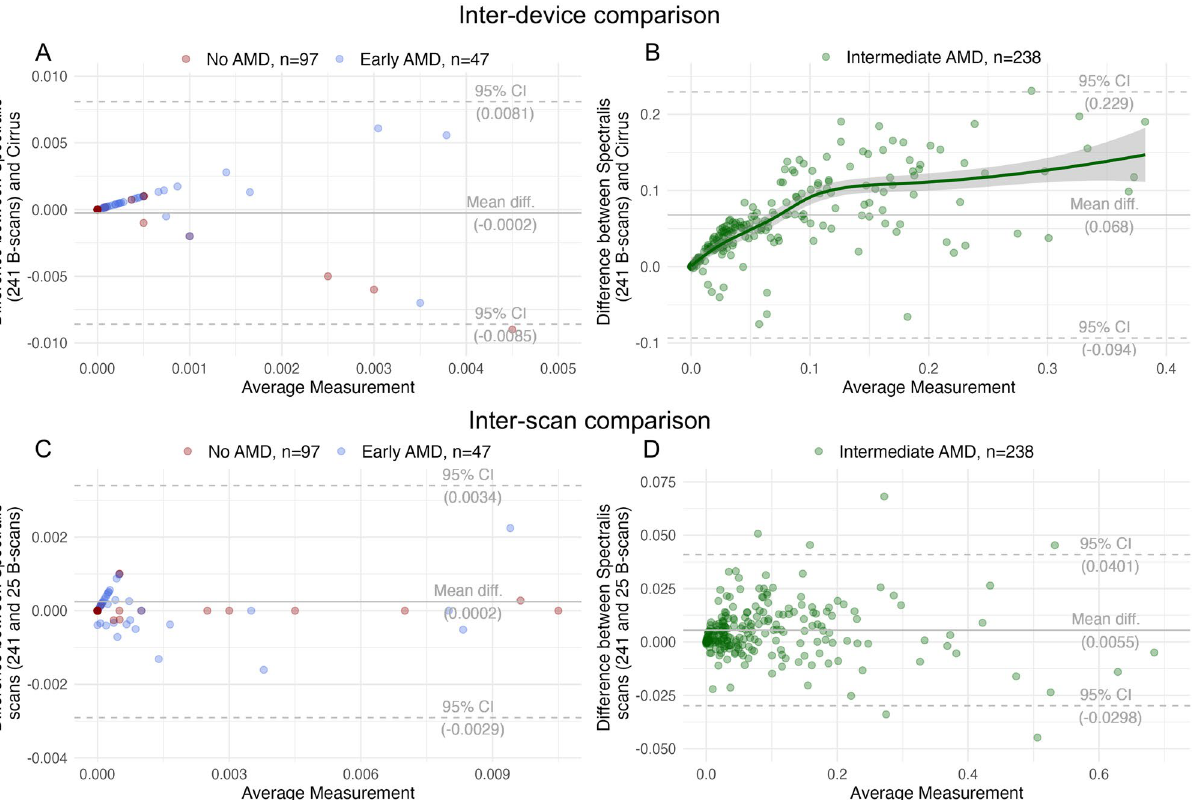
Figure 2. Bland–Altman plot showing differences stratified per AMD stage between the two algorithms ( A , B ) and the two scans ( C , D ), respectively. A Least Absolute Shrinkage and Selection Operator (LASSO) regression line was added in ( B ) to highlight a linear inter-device trend at lower drusen volume measurements and flattening of the curve with increasingly broader confidence intervals at higher values, indicating lower comparability. AMD age-related macular degeneration, diff.